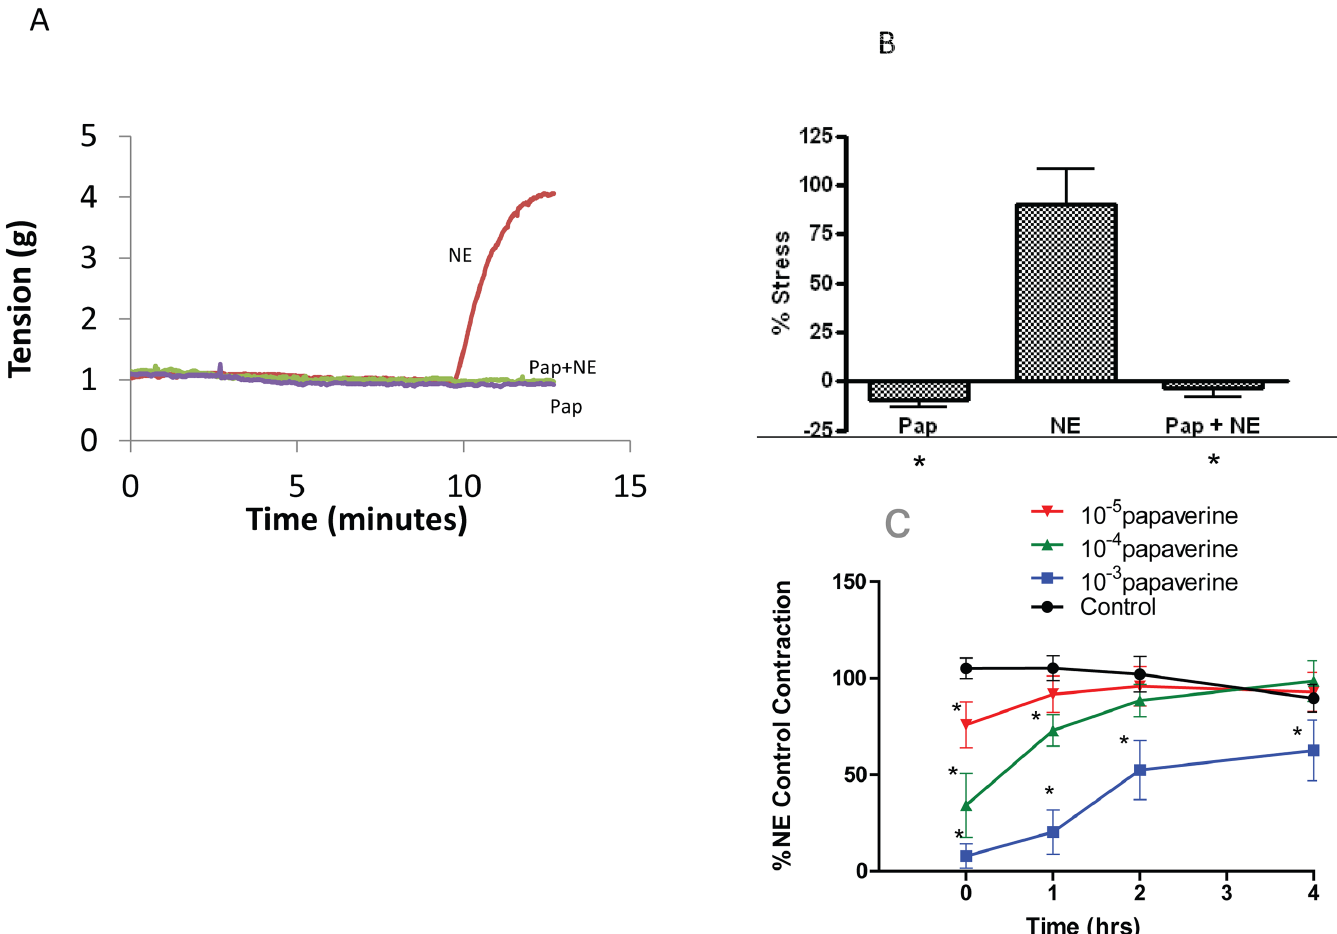
Fig 1. Preincubation with papaverine inhibits norepinephrine (NE) induced contractions in human saphenous vein. Saphenous vein rings were suspended in a muscle bath and equilibrated in Kreb ’ s bicarbonate buffer for 2 h. Panel A: Representative force tracings of rings treated with 0.5 μ M NE, 1mM papaverine (Pap), or 1 mM papaverine for 10 min followed by 0.5 μ M NE. Panel B: Cumulative data obtained when the force was converted to stress and decrease in stress was converted to a percentage of the maximal initial KCl contraction which was set as 100%. Means ± SE, n = 6 P < 0.05. * Significant compared to NE. Panel